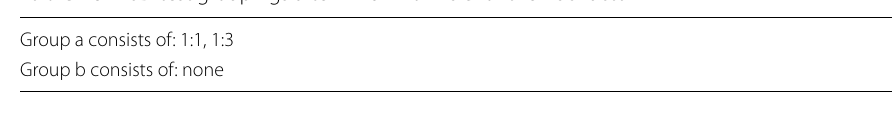
Table 10 HSD test groupings after ANOVA of AUC for the RUS factor